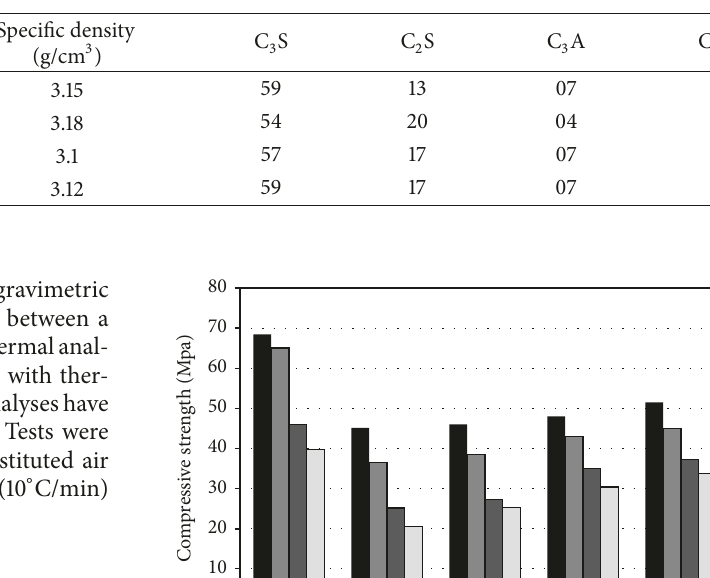
Table 3: Mineralogical composition (%) and physical characteristics [33, 34].